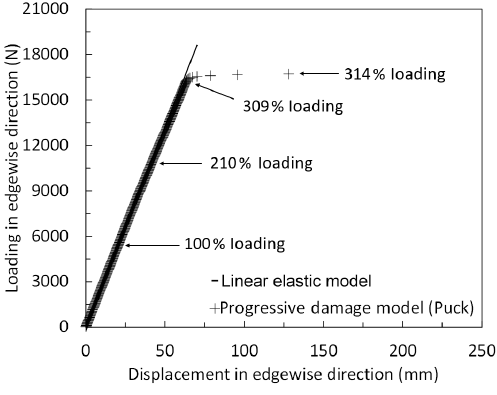
Figure 20. Load–displacement curves of the blade using the linear elastic model and progressive damage model (Puck) under extreme edgewise loading.